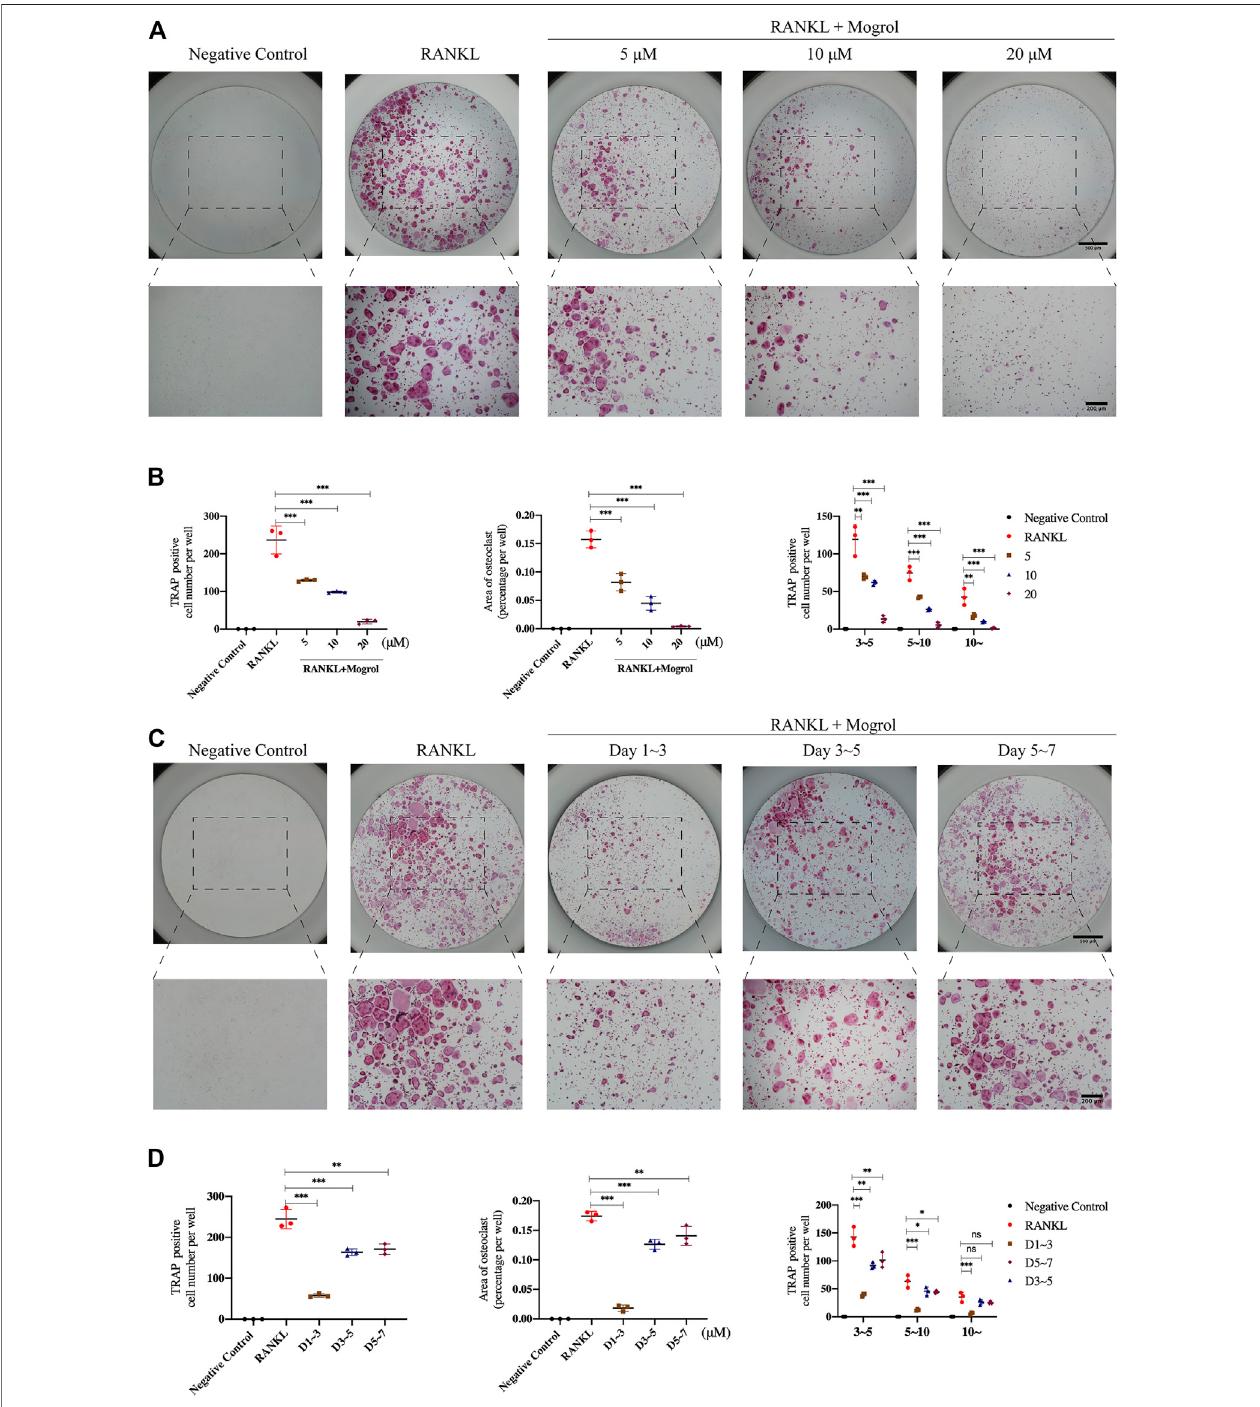
FIGURE 2 | Mogrol attenuated RANKL-activated osteoclastogenesis by time- and dose-dependently. (A) BMMs cultured with 0, 5, 10, or 20 μ M mogrol with the stimulation of 30 ng/ml RANKL (or not). After 5 days, these cells were fi xed and stained with TRAP ( n = 3). (B) TRAP-positive multinucleated (there or more) cells were regarded as mature osteoclasts. Quantity, area and size of mature osteoclasts were quanti fi ed and analyzed. (C) Images of TRAP staining of BMMs stimulated without (negative control group) or with RANKL and treated without (positive control group) or with 20 μ M for 1, 3, and 5 days ( n = 3). (D) Osteoclast number, osteoclast area, and osteoclast size were all quanti fi